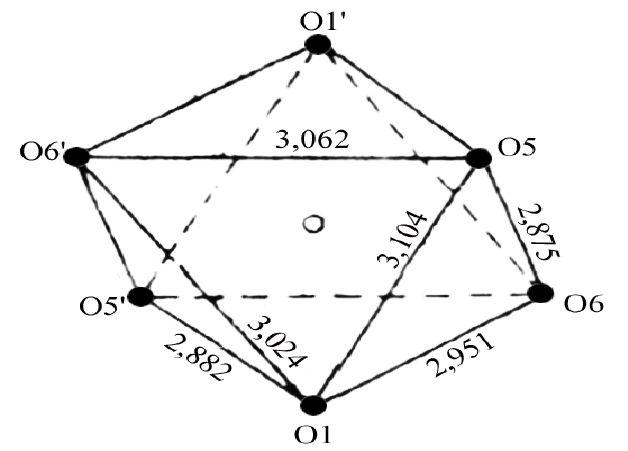
Figure 5 . Octahedral environment of the cobalt atom